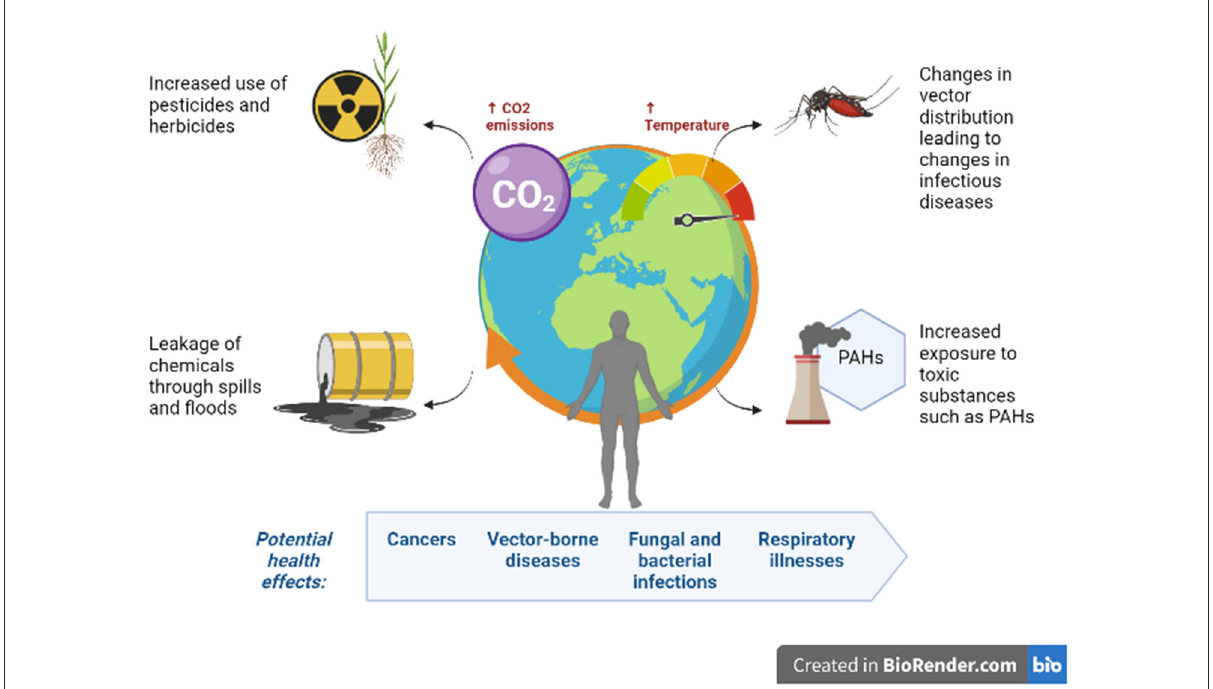
FIGURE1 Climate change-induced environmental exposures and their potential health